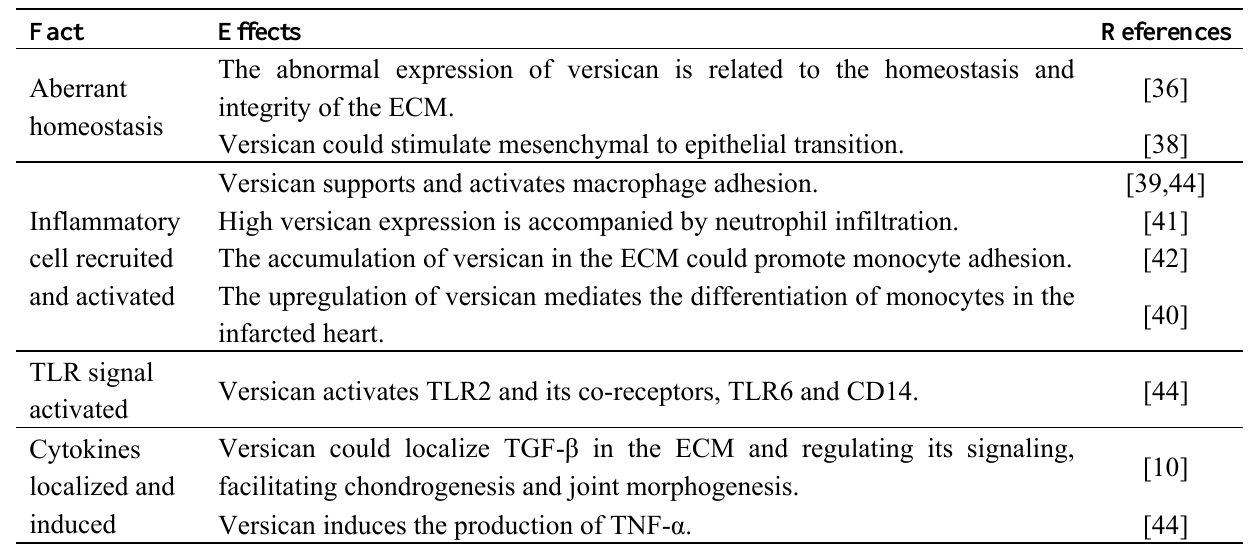
Table 2. Role of versican in inflammation-associated